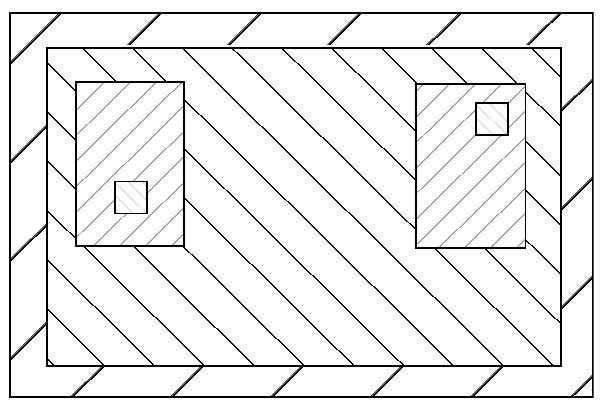
Table 4. Synopsis of spatial structure for realistic test case.